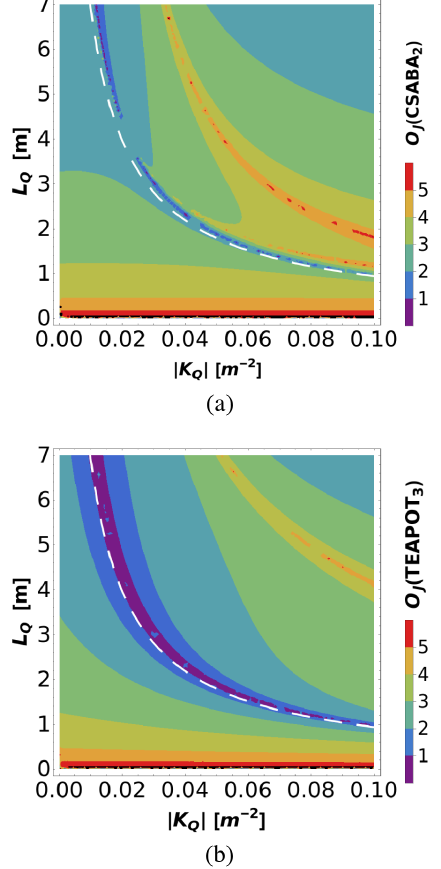
FIG. 2. The order of accuracy of J in a FODO cell, for different K and L with the use of (a) the CSABA 2 and (b) the Q Q TEAPOT 3 symplectic integrators. The area below the white dashed curve guarantees stable motion through the FODO